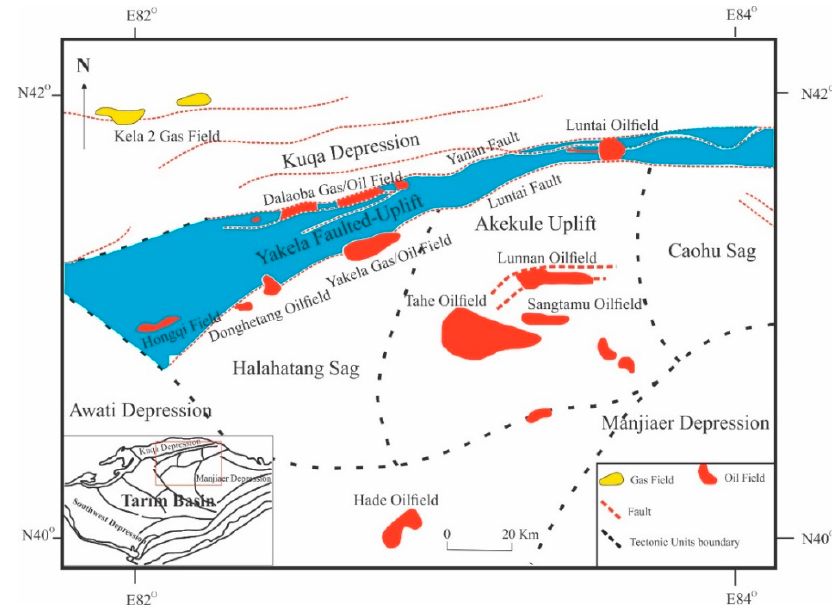
Figure 2. Tarim Basin tectonic units and Yakela Faulted Uplift localization.